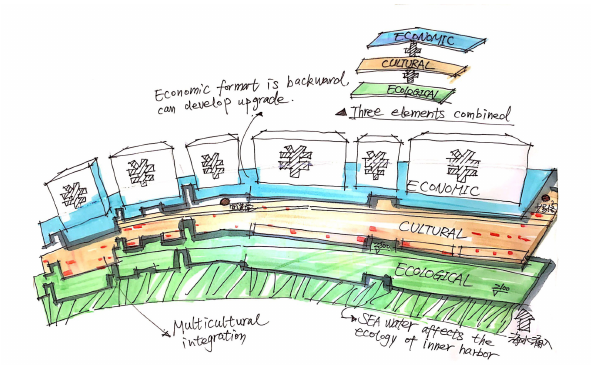
Fig. 3 Integration of economy, culture and